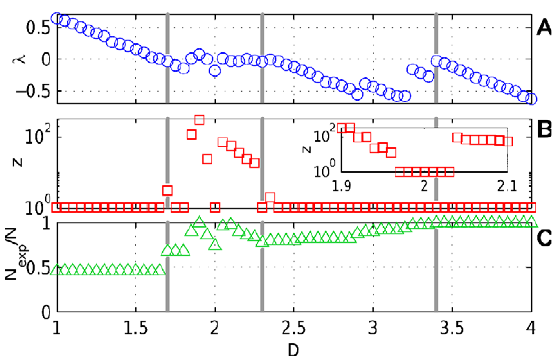
Figure 4. Degradation rates and active networks. Example of a SL system with N ~ 50 and S k T ~ 10 and identical initial conditions for all values of D expressing different portions of the regulatory networks. (a) The Lyapunov exponent, (b) the number of active sets z in a period (if z ~ 1 then the sequence is not periodic but a steady state!), and (c) the fraction of expressed nodes are plotted as functions of the uniform decay rates D i ~ D . For D w 3 : 4 x (cid:2) is stable. In the range 2 : 4 v D v 3 : 4 the x (cid:2) has become unstable but the plateau ( l ~ 0 ) can not form since the dynamic finds active sets s with stable and accessible x (cid:2) s in (b) shows that in the plateau region a small window, 1 : 97 v D v 2 : 03 , exists where again an active set s contains an accessible x (cid:2) s the dynamics. In the range 1 : 7 v D v 2 : 4 the plateau forms and dynamics gets periodic. For D v 1 : 7 the system gets unstable.